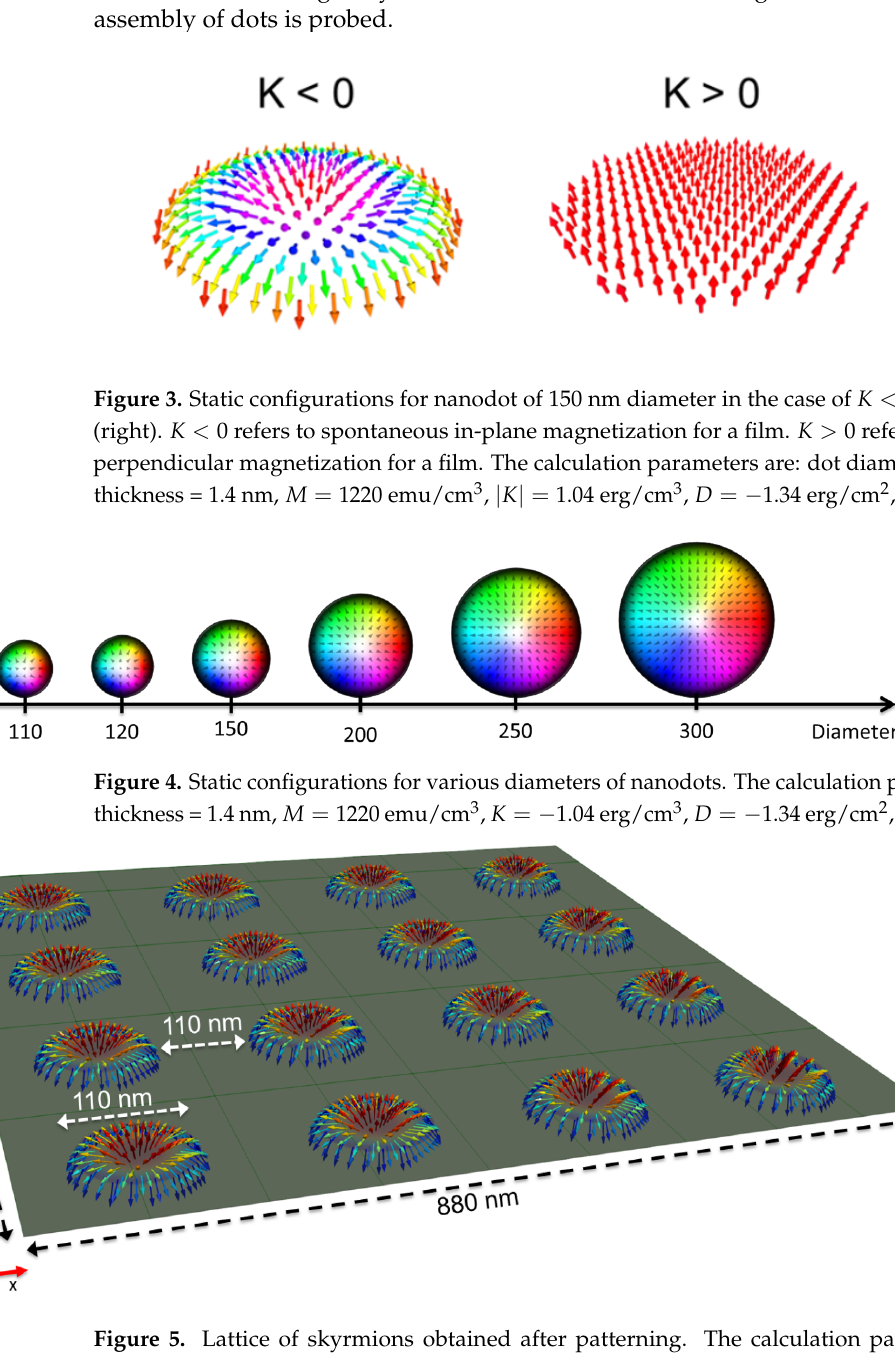
Figure 5. Lattice of skyrmions obtained after patterning. The calculation parameters are: dot thickness = 1.4 nm, M = 1220 emu/cm 3 , K = − 1.04 erg/cm 3 , D = − 1.34 erg/cm 2 , A = 1.6 µ